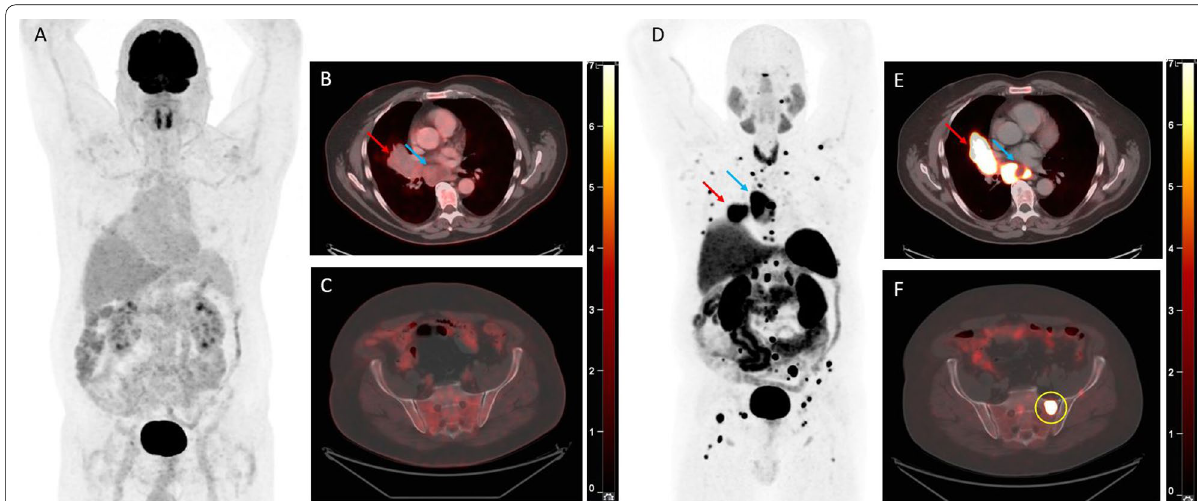
Fig. 5 MIP image of an [ 18 F]FDG PET/CT scan (A) and a [ 68 Ga]Ga‑DOTATATE PET/CT scan (D) performed during staging of a typical bronchial carcinoid tumour (TC) of a 62‑year‑old patient with a clear discrepancy between an intense [ 68 Ga]Ga‑DOTATATE uptake (E) and no increased [ 18 F] FDG uptake (B) in the primary tumour (red arrow) as well as in a subcarinal lymph node metastasis (blue arrow). The axial fusion images with CT in bone window of the [ 18 F]FDG PET/CT (C) and the [ 68 Ga]Ga‑DOTATATE PET/CT (F) also show this discrepancy with regard to the bone metastases. The bone metastasis in the left hemisacrum (yellow circle) has a SUV max on [ 68 Ga]Ga‑DOTATATE PET/CT of 39.6. A chest CT 53 days before the [ 68 Ga] Ga‑DOTATATE PET/CT did not show any bone metastasis